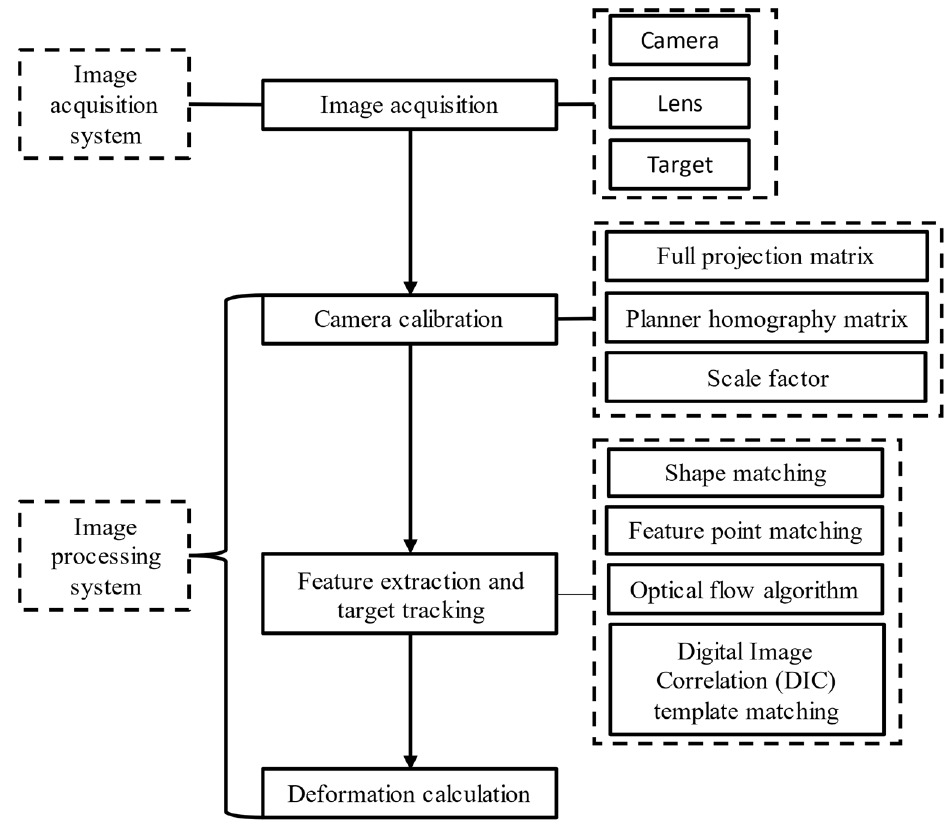
Figure 1. Process of deformation monitoring based on computer vision.